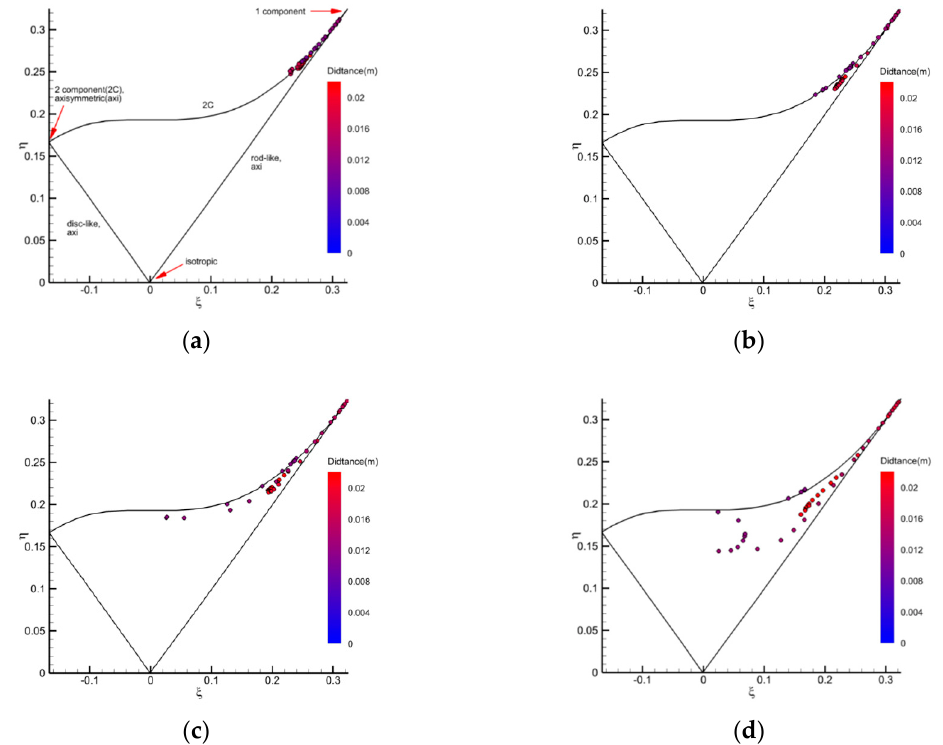
Figure 19. Distribution of points from the extracted lines in the Lumley triangle at 10% span: ( a ) No.1; ( b ) No.2; ( c ) No.3; ( d ) No.4.